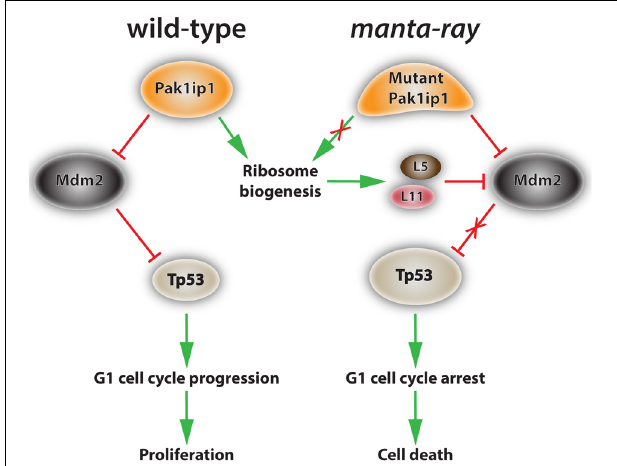
FIGURE 3 | Proposed mechanism of action of Pak1ip1 in both wild-type and homozygous manta-ray mutants. In the wild-type (left) Pak1ip1 acts as an inhibitor of the E3 ubiquitin ligase Mdm2, which acts as an inhibitor of Tp53 activity through an auto-regulatory feedback loop. Mdm2 targets Tp53 for degradation by the proteasome, blocks its transcriptional activity, and facilitates its export from the nucleus. Low levels of Tp53 activity promote cell cycle progression at the G1 checkpoint and cellular proliferation. In the manta-ray mutant (right) Pak1ip1 causes altered 60S ribosome biogenesis, resulting in nucleolar stress and the accumulation of freely circulating ribosomal proteins L5 and L11, which inhibit Mdm2 activity. This series of events leads to an increase in Tp53 levels, G1 cell cycle arrest, and subsequent cell death, which appears to particularly affect aspects of the cranial neural